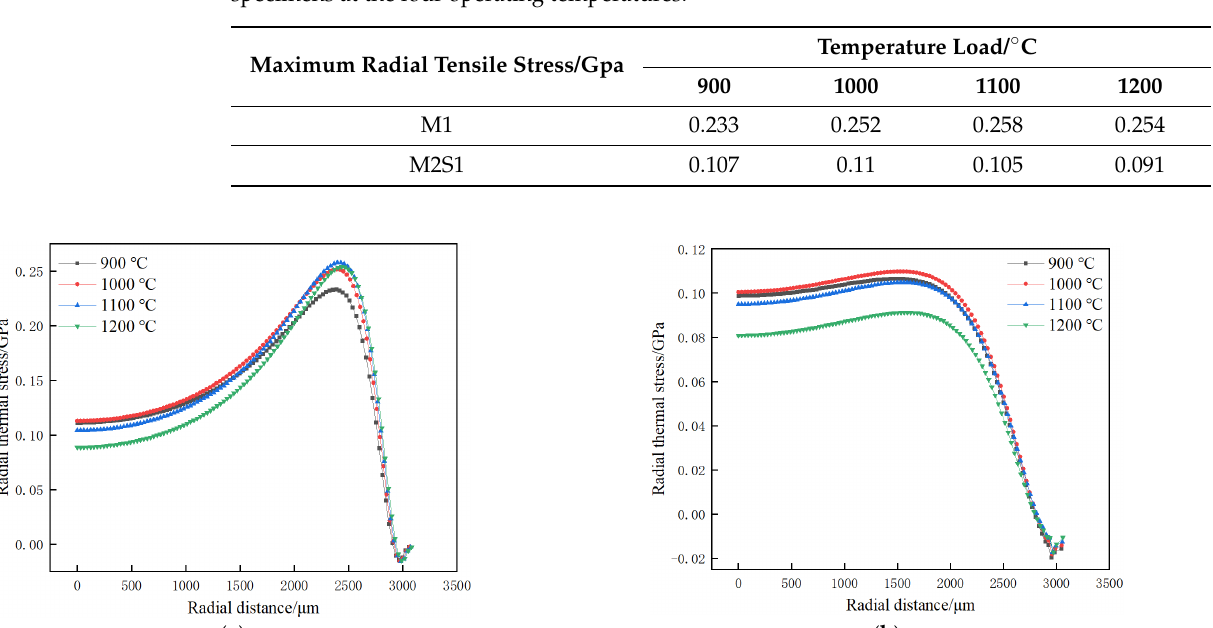
( b ) Figure 6. Relationship between the maximum radial thermal stress on the surface of the LMA layer of the ( a ) M1 and ( b ) M2S1 specimens and the operating temperatures. Figure 7. Comparison of the shear thermal stress distribution on the surface of the LMA layer of the M2S1 specimen at four operating temperatures.